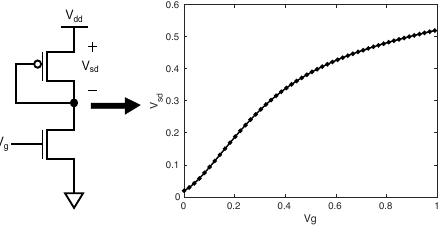
Figure 2. CS amplifier and its transfer function.